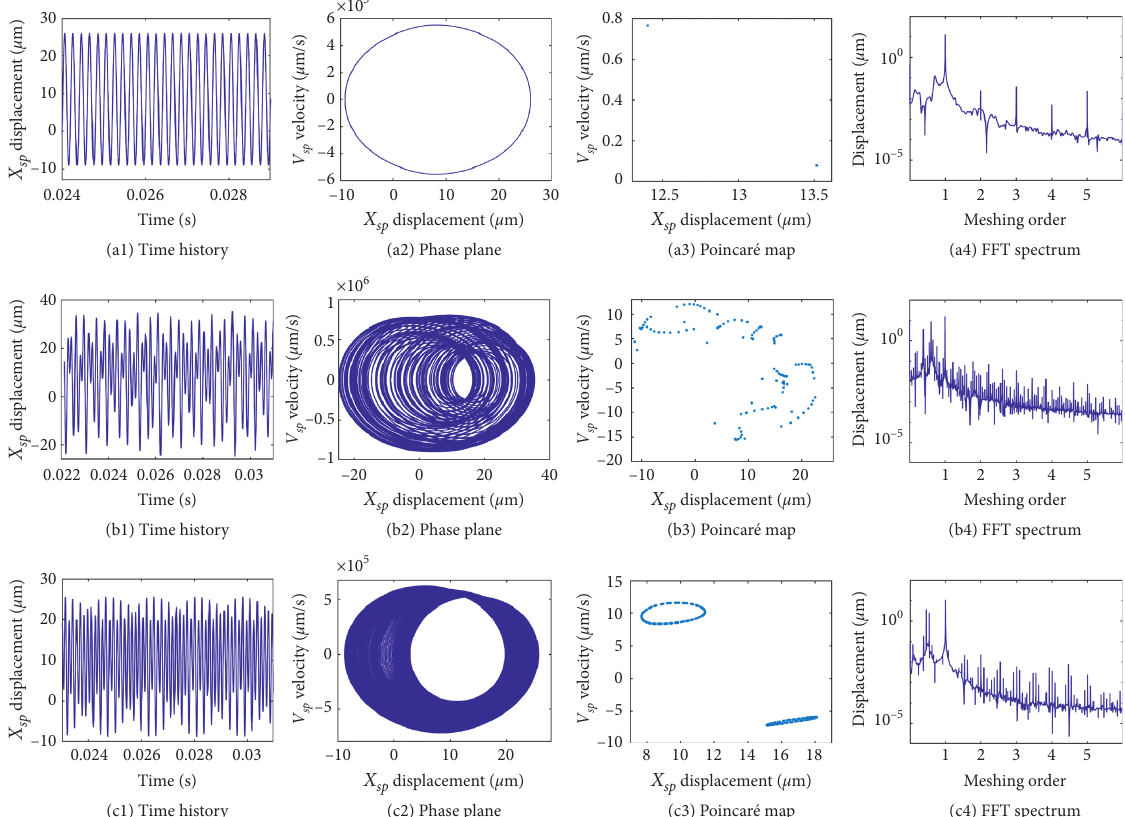
Figure 9: Vibration response of sun gear and star gear meshing pair: (a) n � 7000, (b) n � 8200, (c) n � 10000.